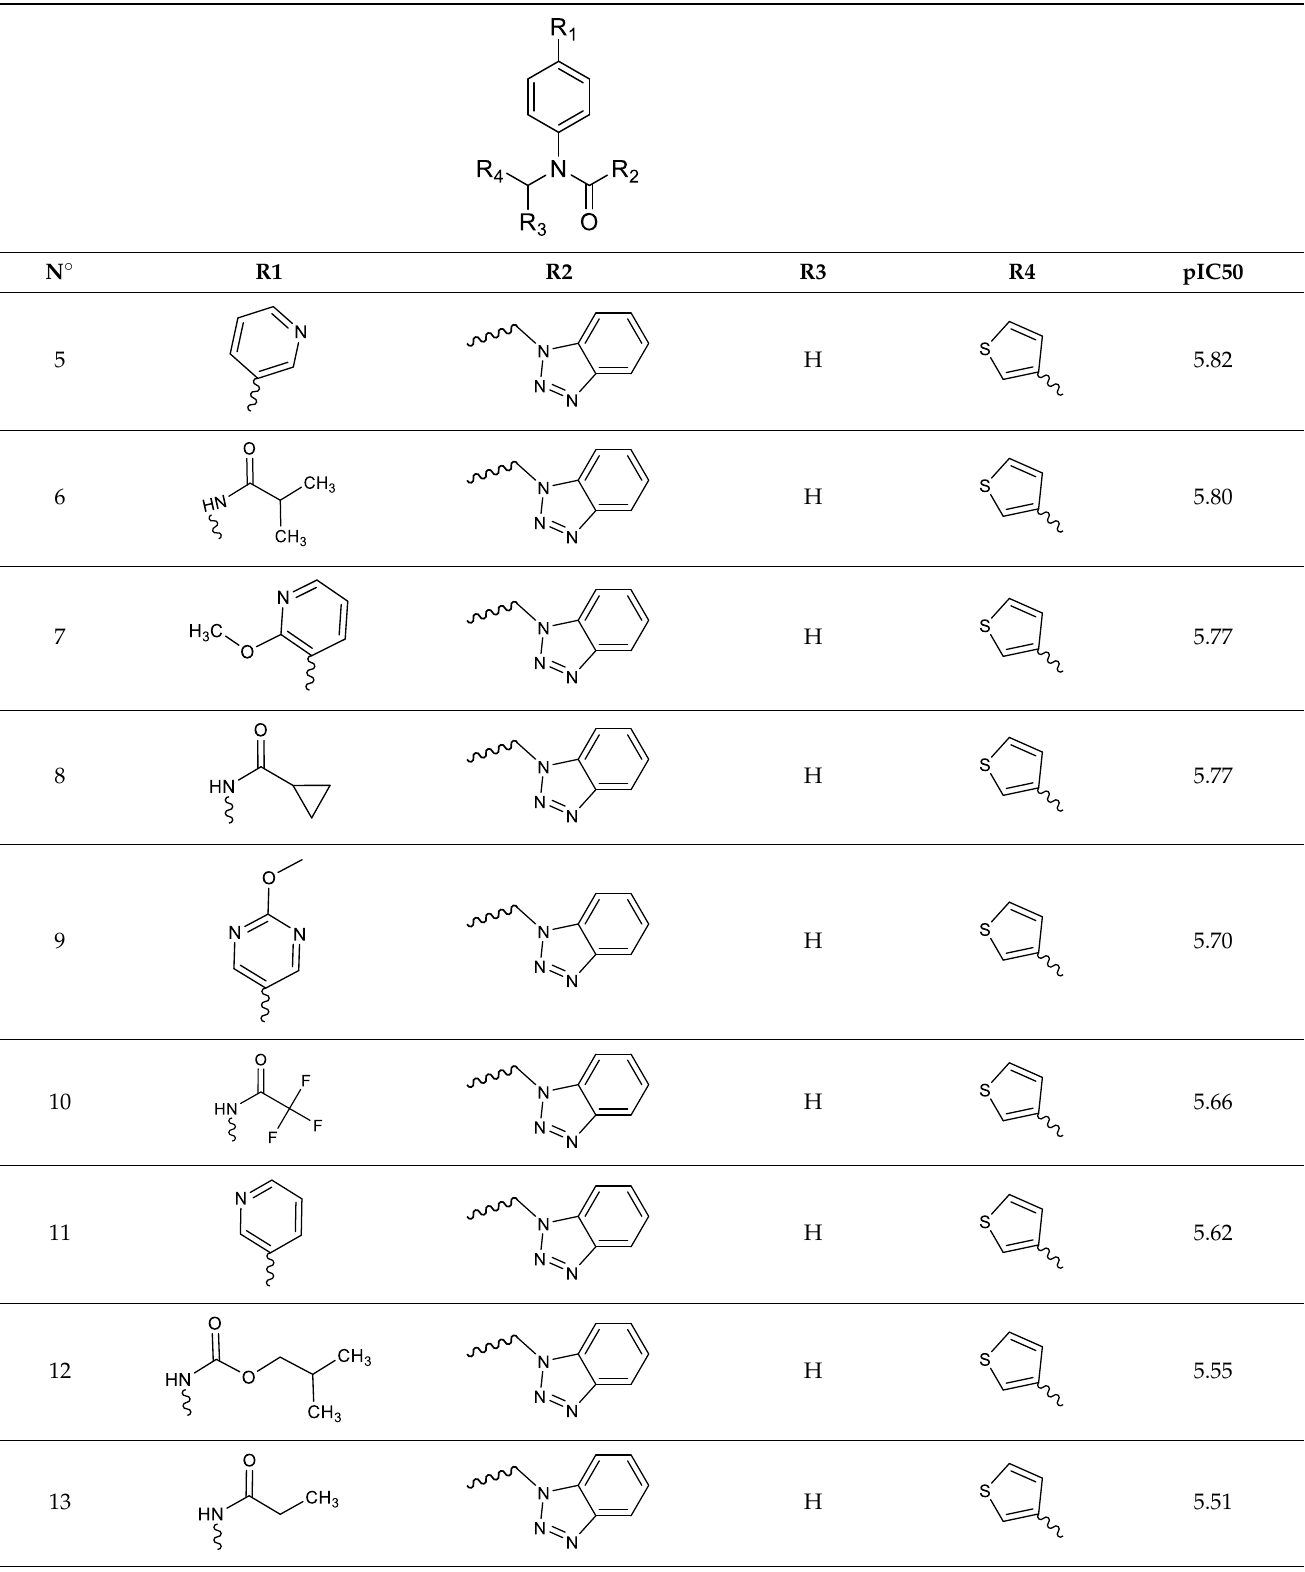
Table 1. Chemical structures and activity experiment of 41 peptidomimetic compounds.